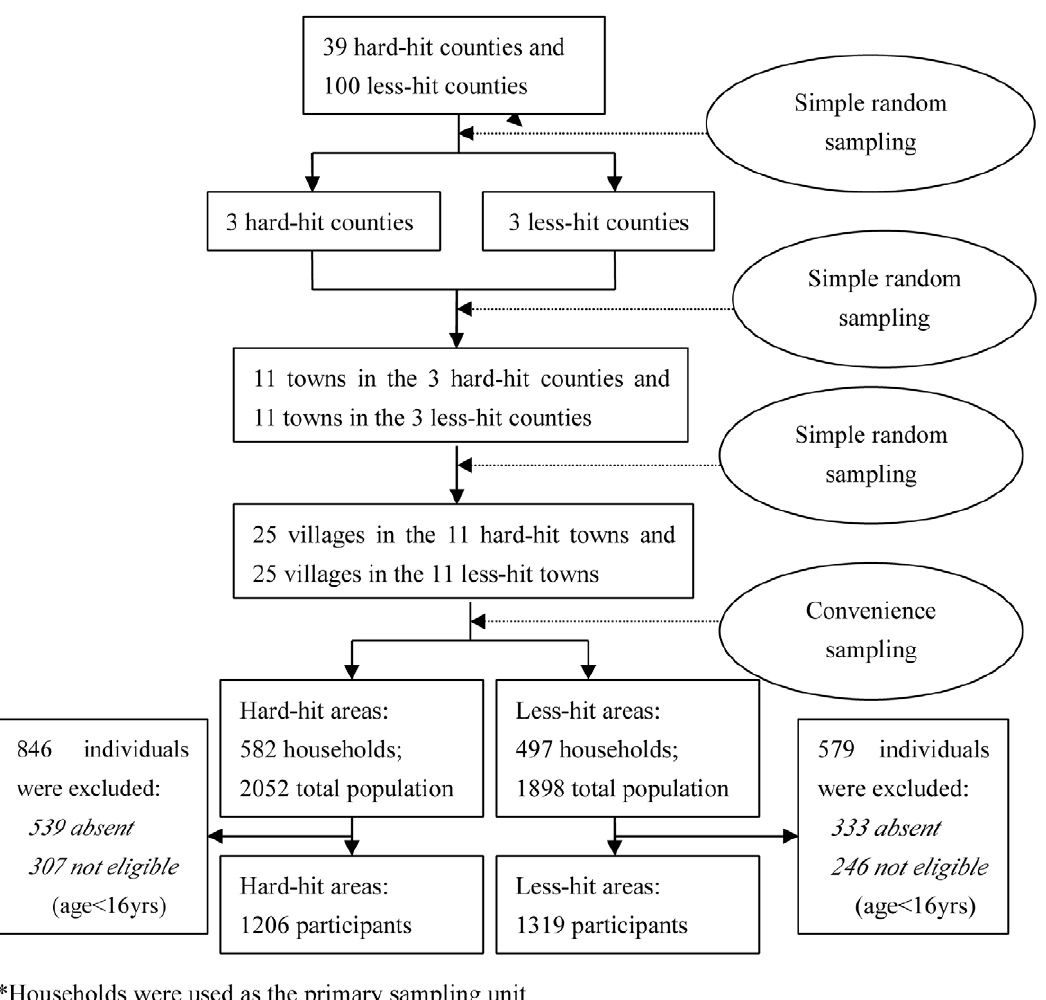
Figure 1. Flow chart of sampling stages. *Households were used as the primary sampling unit.